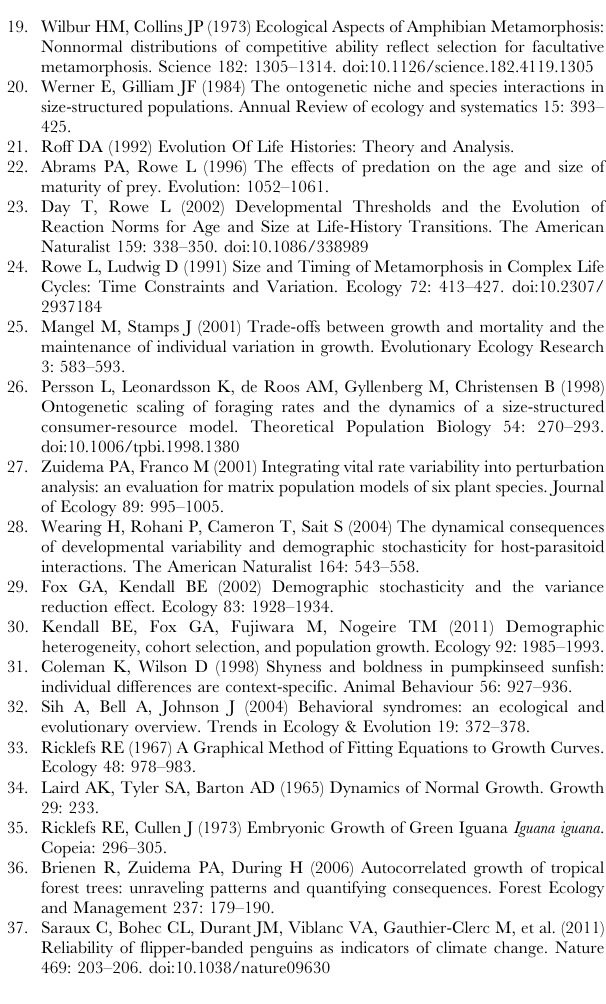
Figure S1 Each panel contains results of fitting the model to data sets with different amounts of growth autocorrelation ( r 2 = 0.25, 0.49, 0.81). Realized mortality rate (the proportion of individuals that died by the end of the experiment) is plotted on the x-axis. Estimated values of r 2 for each simulation are plotted as grey dots. Red lines represent the true value of r 2 . Blue lines summarize the simulations grouped by the total increase in size variation that would have been realized without mortality ( s 2 ). Smooth functions were fit with B-splines with five degrees of